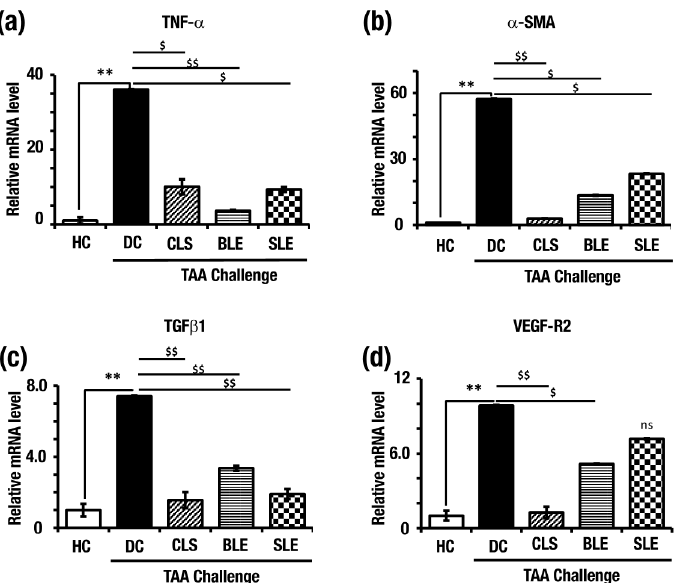
Figure 7. mRNA expressions confirmed the establishment of liver cirrhosis in DC and the hepato- protective effect of aqueous extracts in the other treatments. ( a ) Tnf- α , ( b ) α -Sma , ( c ) Tgf- β 1 and ( d ) Vegf-R2 mRNA expressions determined by qPCR. Expression levels are normalized to 18S mRNA level. Error bars represent standard errors of the means (SEM) in each group (n = 5). The statistical significances are indicated in two ways; (i) disease induction effect during the TAA challenge (HC vs. DC), (ii) O. octandra treatment consequence (DC vs. CLS, BLE and SLE), with one-way ANOVA followed by the Dunnett’s test. $, significant decrease; $, p = 0.01 to 0.05, $$, p = 0.001 to 0.01, *, significant increase; **, p = 0.001 to 0.01. ns, p >